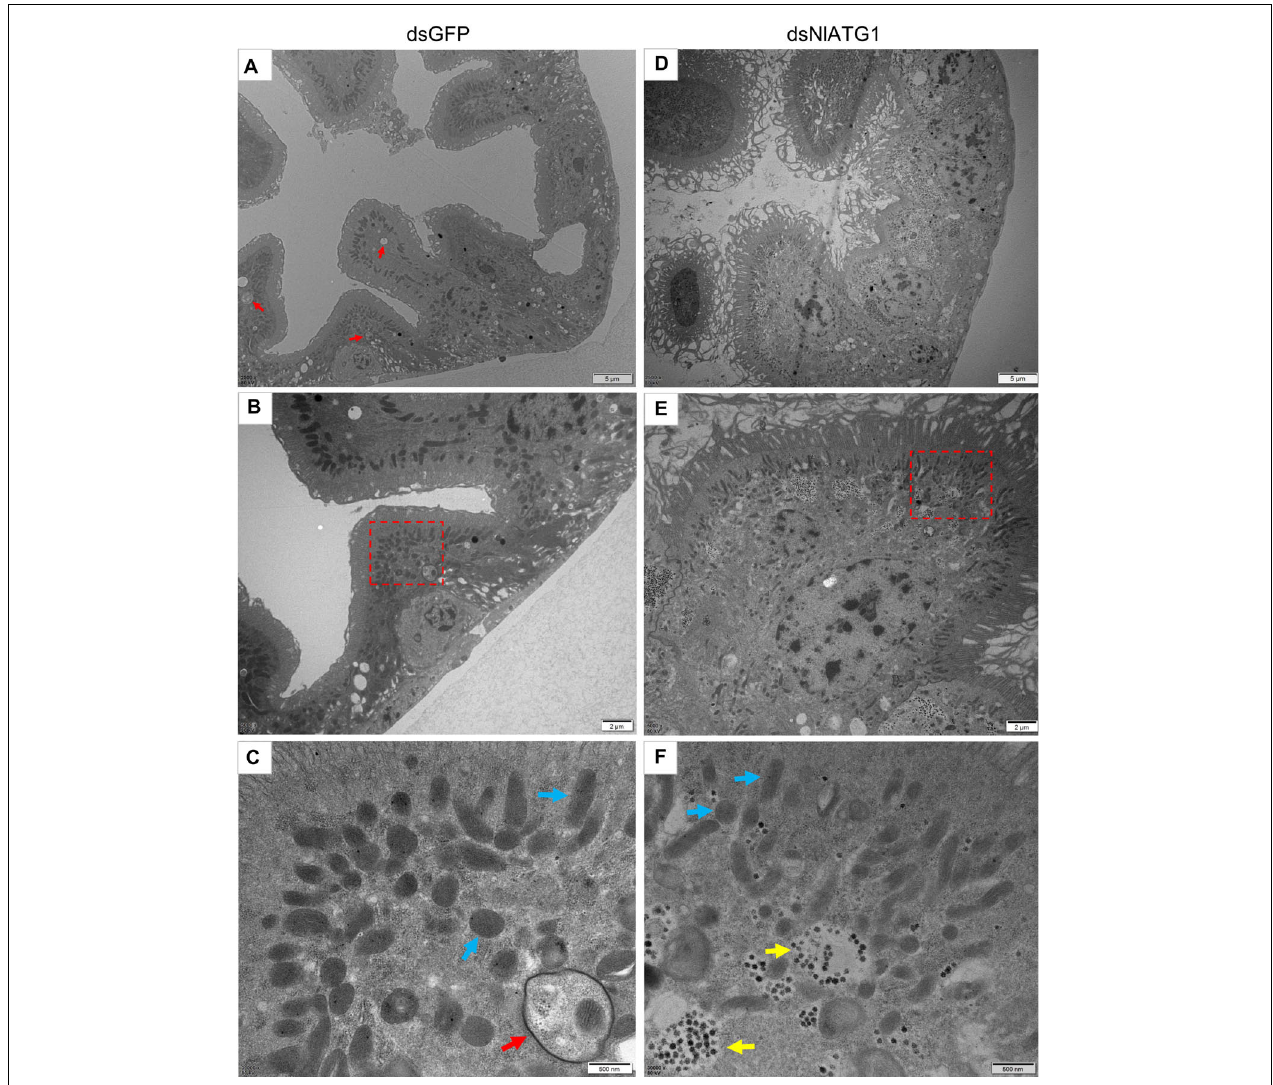
FIGURE 4 | Transmission electron microscopy graphs of epithelial cells in the midgut of BPH (A–C) treated with dsNlATG1 and (D–F) treated with dsGFP, at day 4. Red arrows denote autophagic vacuoles or compartments, blue arrows denote mitochondria, and yellow arrows denote glycogen. (C) Enlargement of the part in a red dotted box in (B) . (F) Enlargement of the part in a red dotted box in (E) . Scale bars: (A,D) , 5 µ m; (B,E) 2 µ m; (C,F) 500 nm. At least three biological replicates were performed per